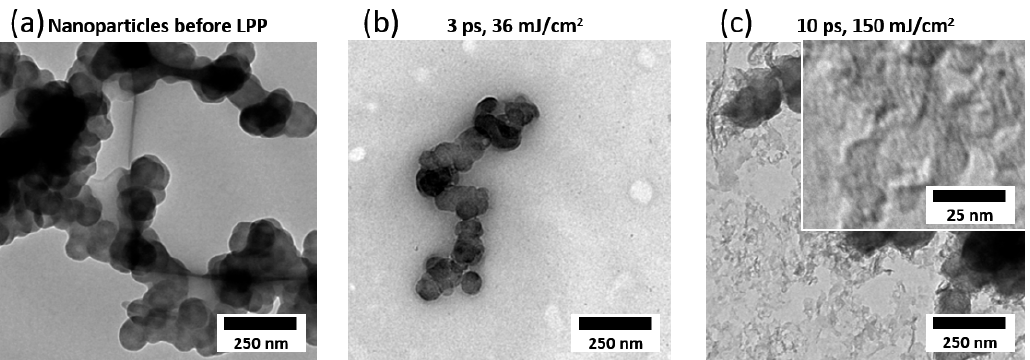
Figure 3. TEM analysis of ( a ) the raw carbon nanoparticles dispersed in water by ultrasonication and ( b , c ) colloids produced by irradiation with ( b ) a low fluence (36 mJ / cm 2 ) and ( c ) a high fluence laser system (150 mJ / cm 2 ). LPP with a high fluence laser system results in many small particles, but the colloid is more unstable against aggregation than at low fluence.